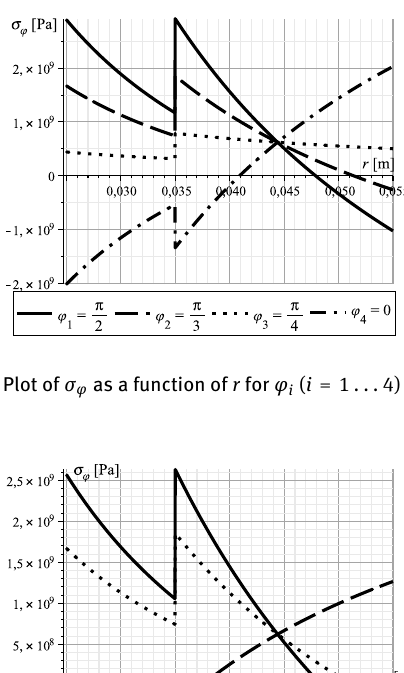
Figure 18: Plot of S ( φ ) (Example 5.2).